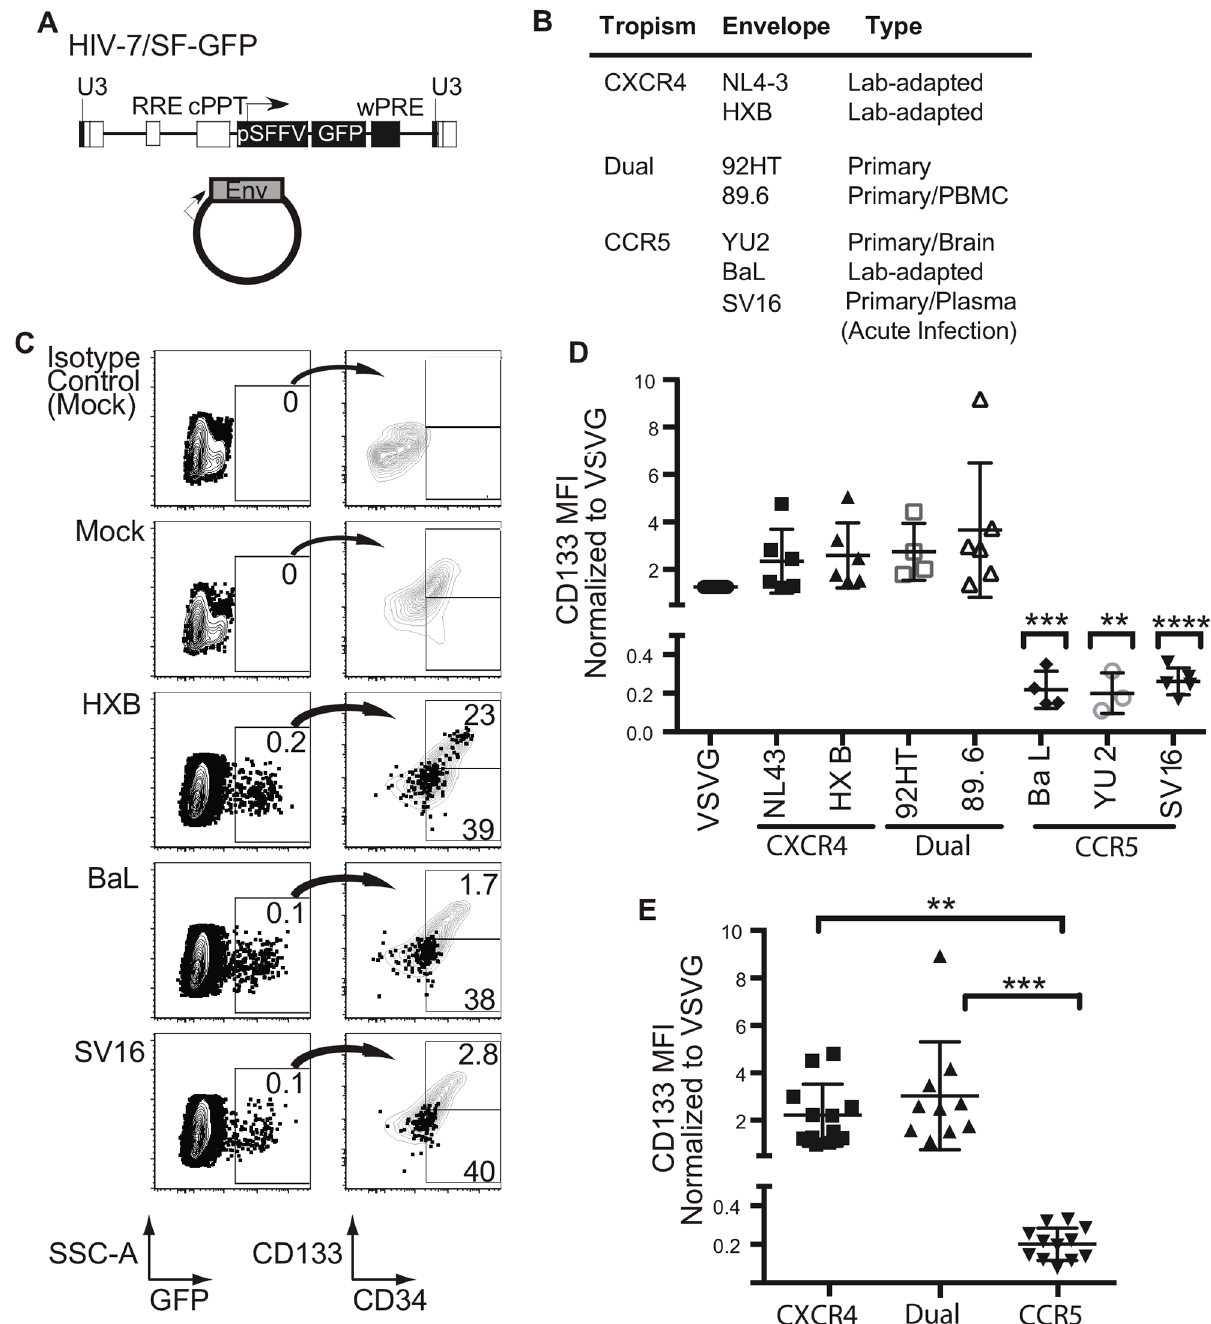
Fig 5. Targeting of intermediate progenitors by CCR5-tropic Envs is a conserved property extending to a transmitted/founder virus. A. Schematic of HIV-7/SF-GFP construct and HIV envelopeplasmidused to construct pseudotyped viruses used in C-E. B. Summary table of envelope proteins used to pseudotypeHIV-7/SF-GFP virus. C. Representative flow plots of cord blood-derived CD133-sorted cells expandedfor four days, transduced with the indicatedvirus and harvested3 days post-infection for flow cytometric analysis.In each right panel, GFP + cells were overlaidonto plots of the total cell populationand the percentage of GFP + cells in the CD133 high and CD133 low regions is indicated. Gates were determinedbasedon isotype control antibodystaining (top panel). D. Summary graph of CD133MFI for experiments performed as in C. Results are compiledfrom 11 cord blood experiments. Mean ± standard deviationis indicated; n (cid:21) 3 for each envelope.2-tailedStudent’s t-test indicates significance for each HIV envelopewith respect to VSV-G ( ** p < 0.01, *** p < 0.001, **** p < 0.0001). E. Data from (D) compiledby tropism. Mean ± standarddeviationis indicated;one-way ANOVA, p = 0.0002, with Tukey’s Multiple Comparisons Test indicated( ** p < 0.01 and *** p <